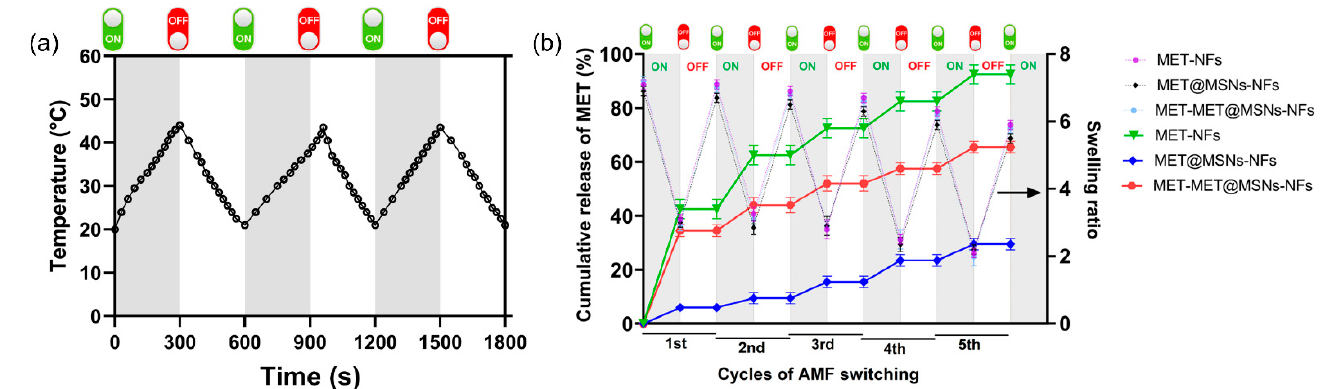
Figure 16. ( a ) Heating and cooling profile of the MET-MET@MSNs-MNFs in response to alternating switching of AMF ( b ) ‘ON-OFF’ switchable and reversible heat profile and swelling ratio of the MNFs with increasing ‘ON-OFF’ switching cycle of AMF, and MET release pattern corresponding to reversible swell-shrink property in response to temperature changes. Reproduced with permission from [103], Copyright © 2021, Elsevier.